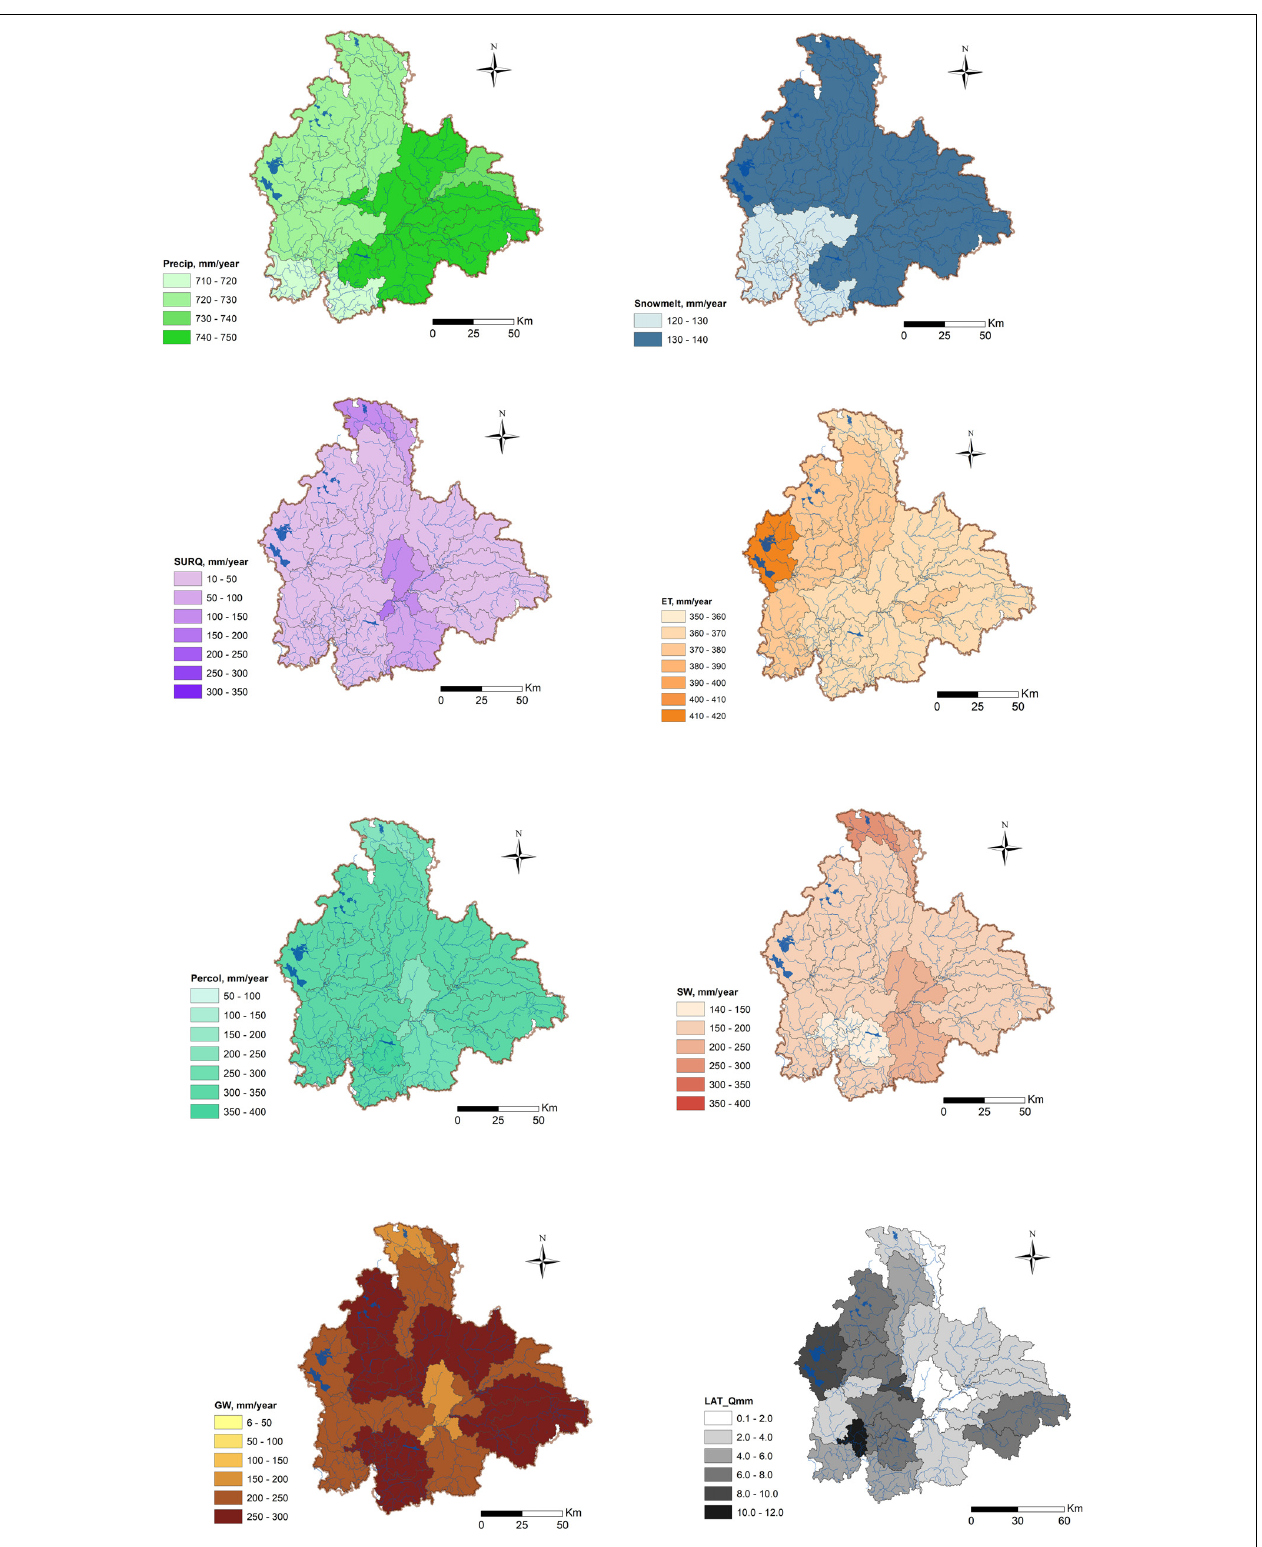
FIGURE 8 | Annual calculated mean water balance components distribution on the Western Dvina catchment area (Precipitation, snowmelt, surface Q, actual ET, percolation, soil water, ground water, and lateral Q).